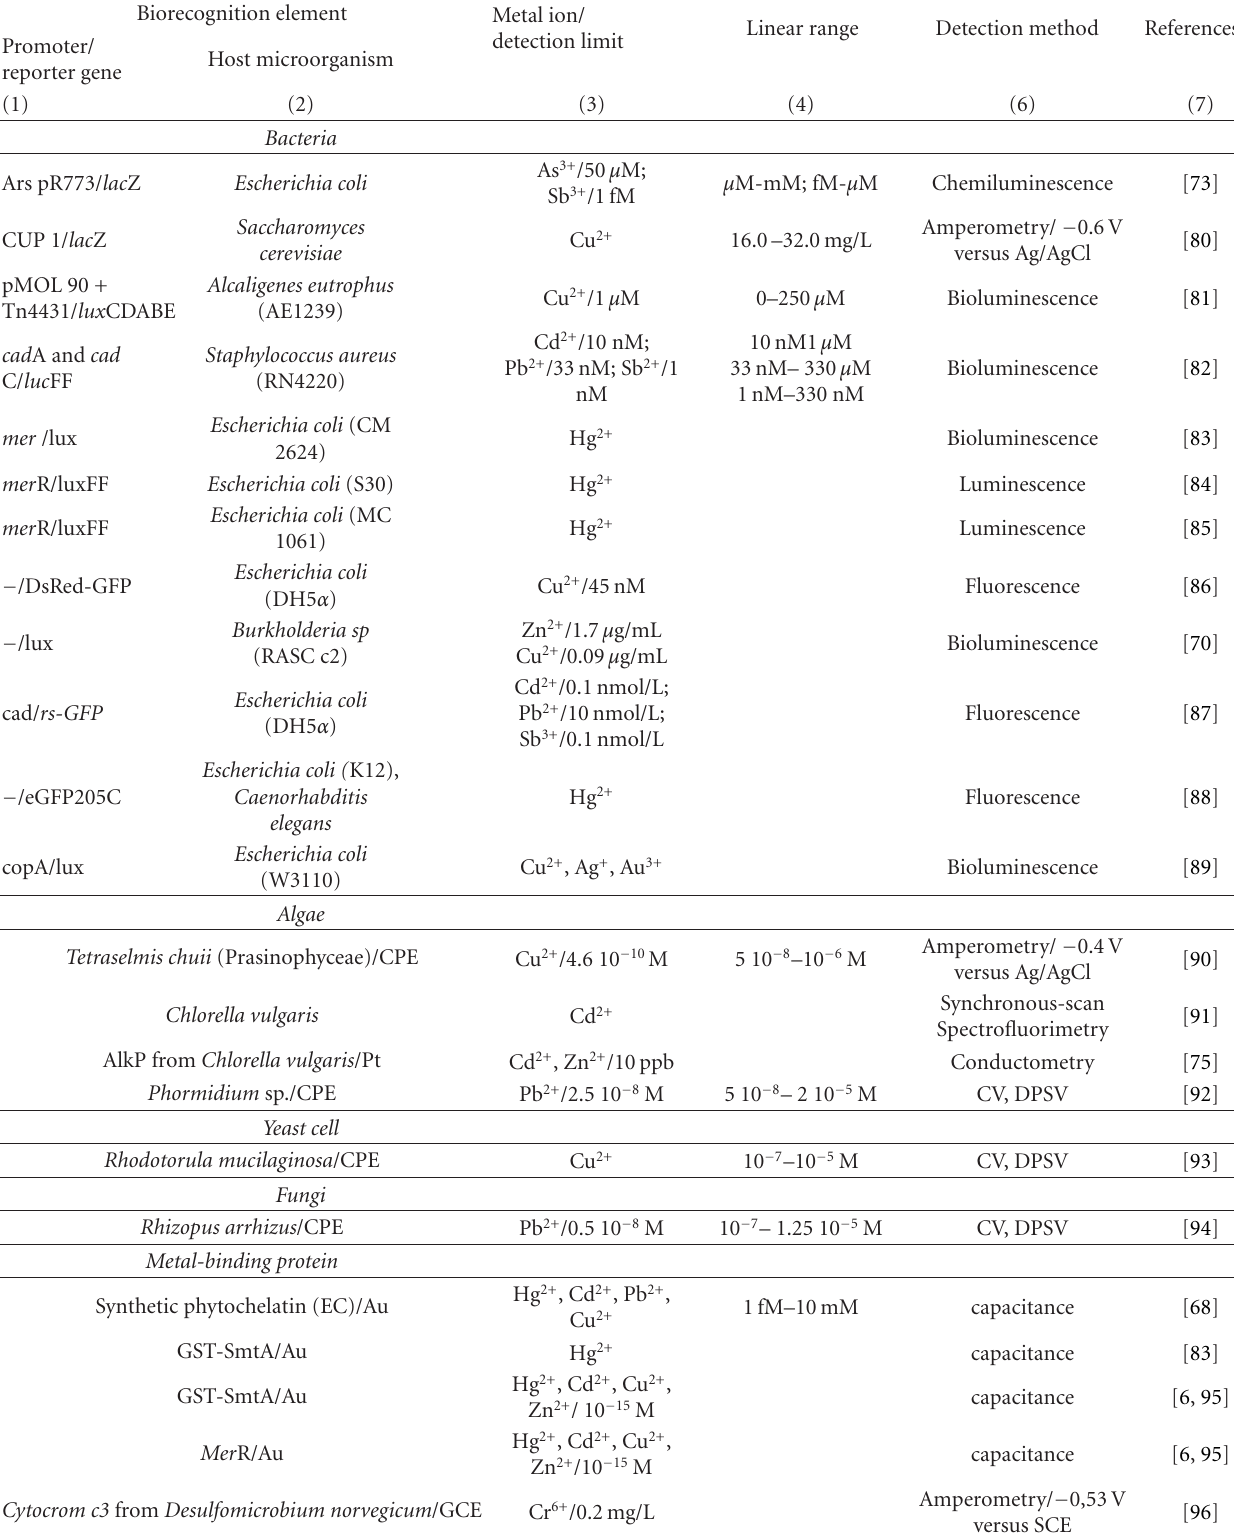
Table 7: Examples of recombinant bacteria for specific heavy metal